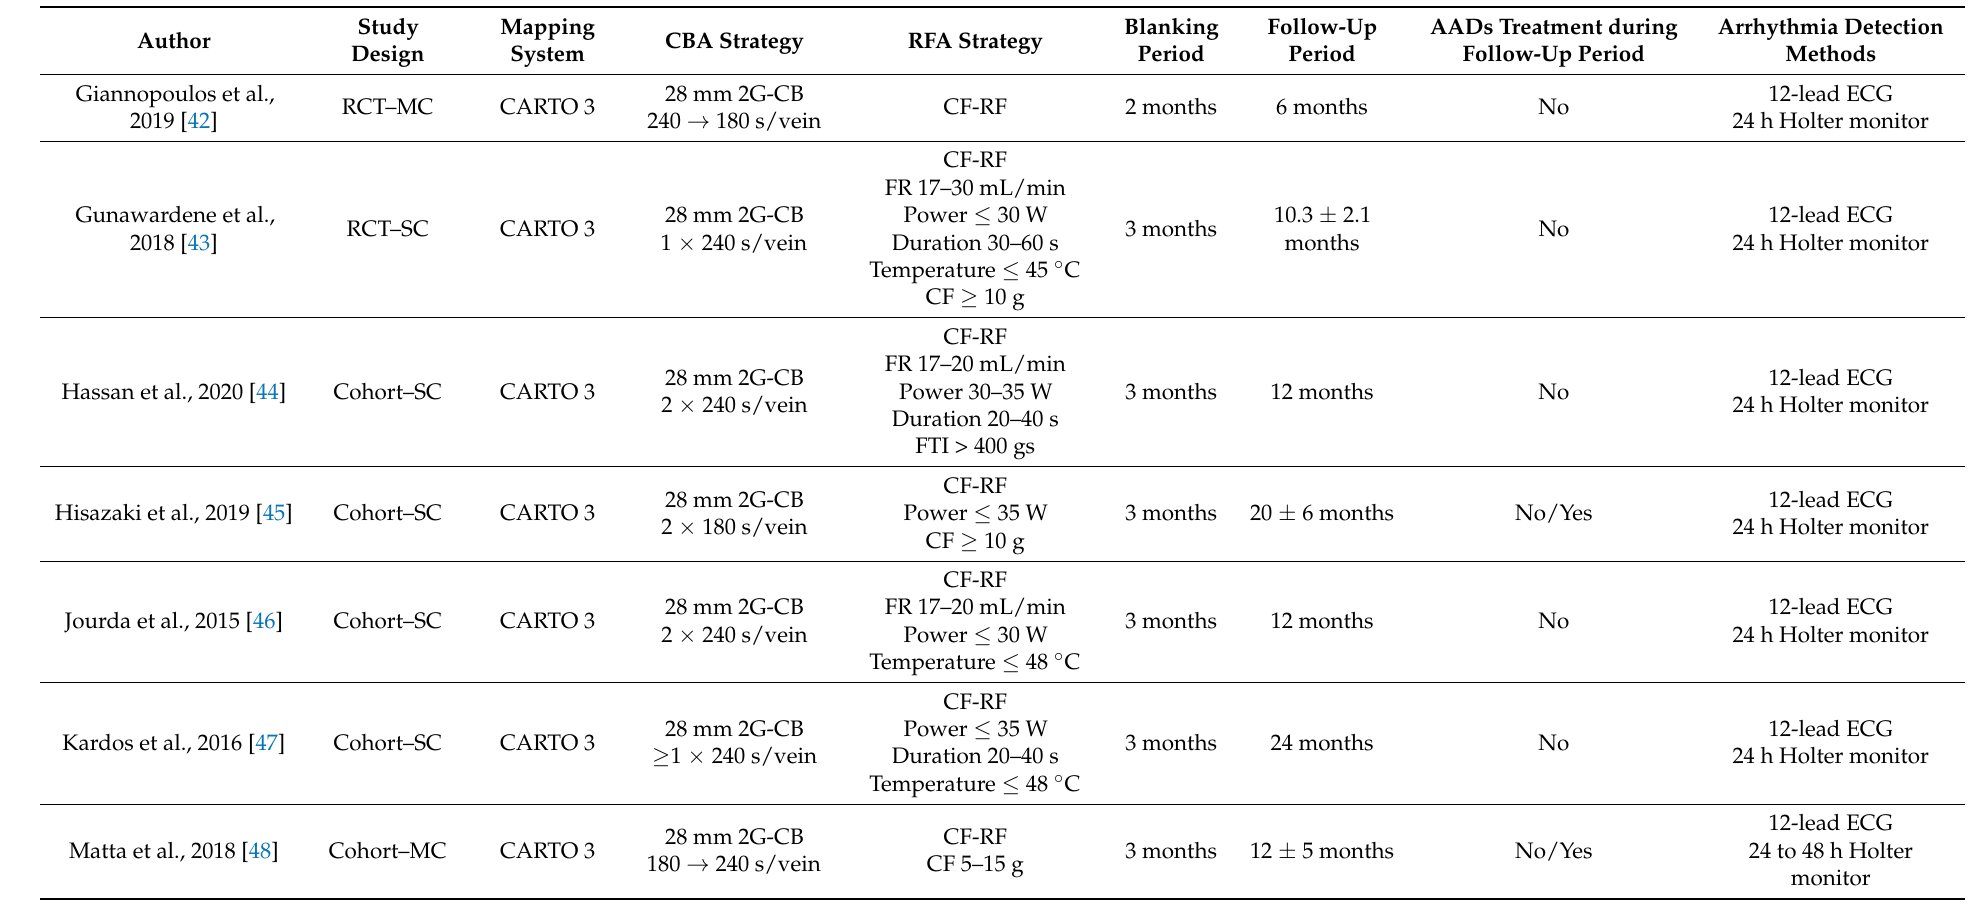
Table 1. Baseline characteristics of the involved